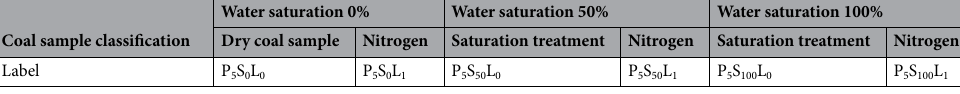
Table 2. Coal sample labeling.